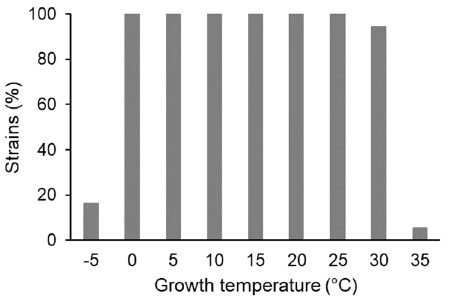
Figure 2. Growth temperature range of the tested bacterial strains (55 =